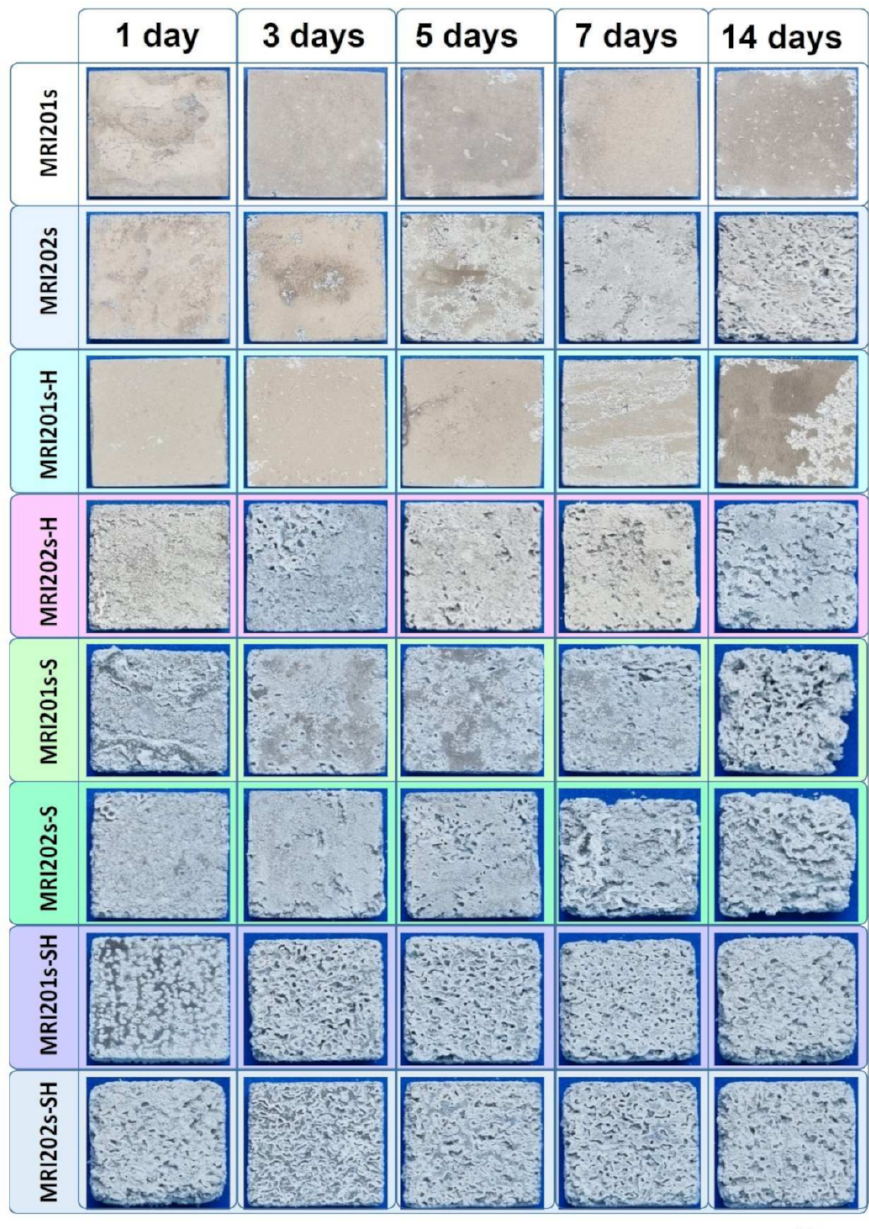
Figure 10. Surface morphologies of the experimental samples after 1, 3, 5, 7 and 14 days of immersion in sodium chloride